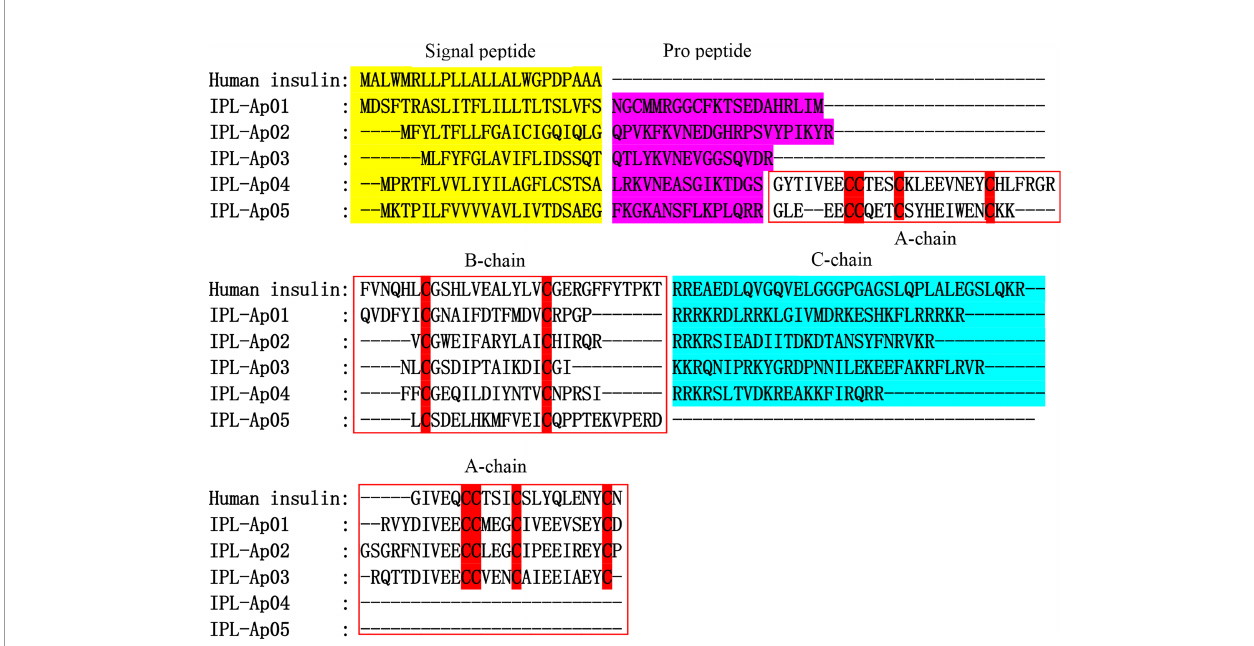
FIGURE 8 | Alignments of the human insulin and fi ve insulin-like peptides (ILPs) from Exaiptasia diaphana . The conserved cysteines are highlighted in red shade. Signal peptide, propeptide and C chain are respectively shown in yellow, purple, and blue. The A chain and B chain boundaries are shown in the red